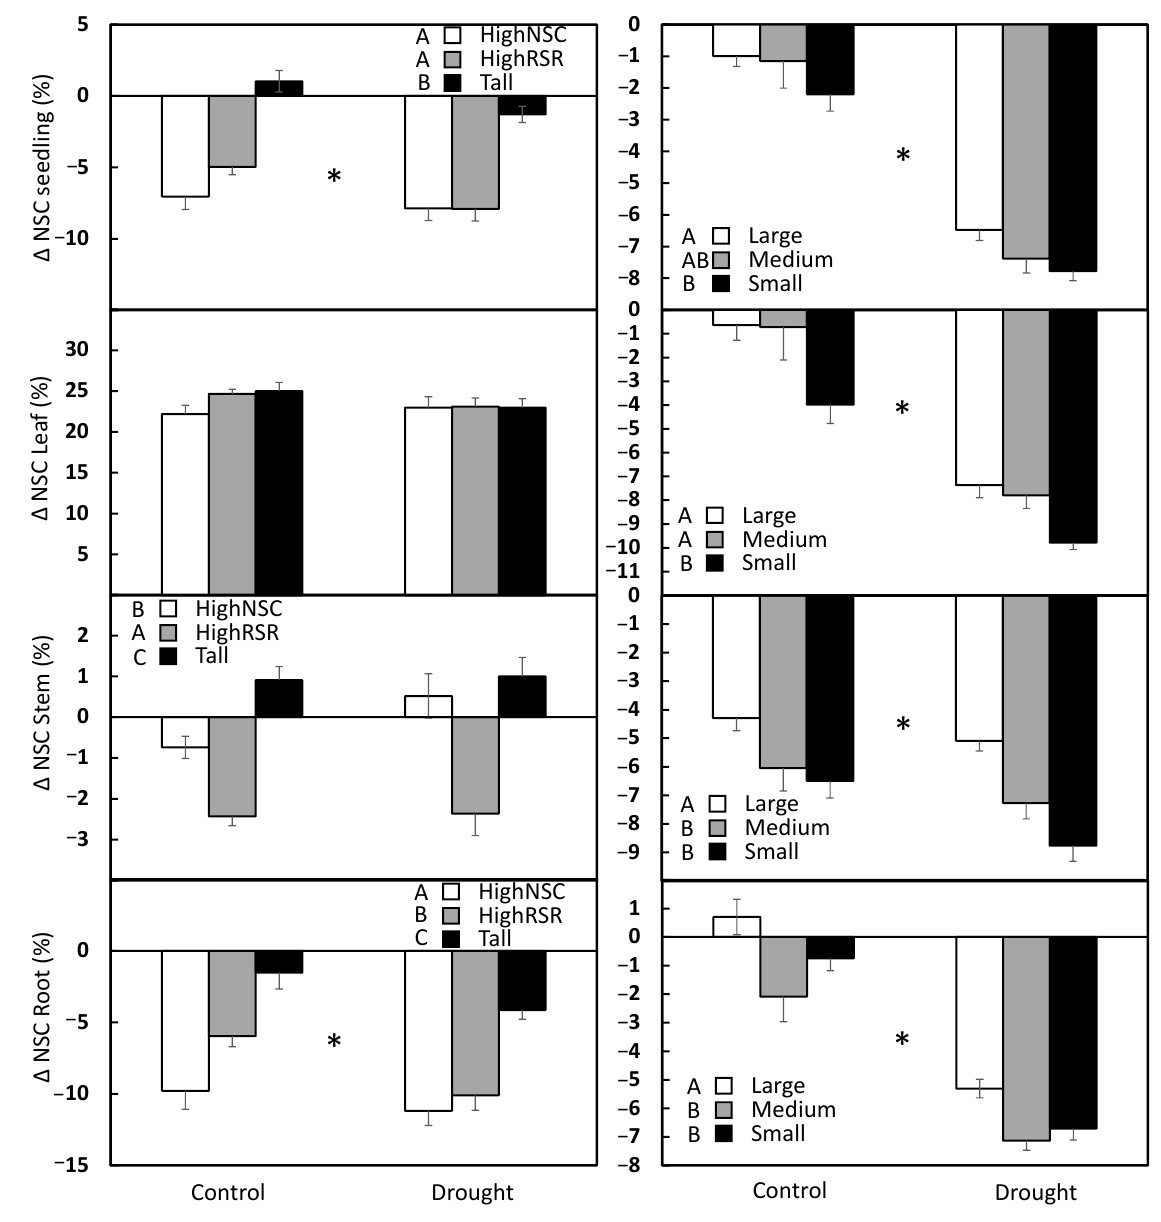
Figure 2. Average ( ± SE) changes in NSC concentration ( ∆ NSC concentration ) at the organ and whole seedling level for aspen (LEFT column) and pine (RIGHT column) seedling types under drought and control conditions. Species and organs were analyzed separately. An * and/or different letters on legend labels indicate significant differences among means of main effects (drought, seedling type), while different letters above bars indicate significant differences among all treatment combination means (Table 1; Tukey’s HSD, p ≤ 0.10).